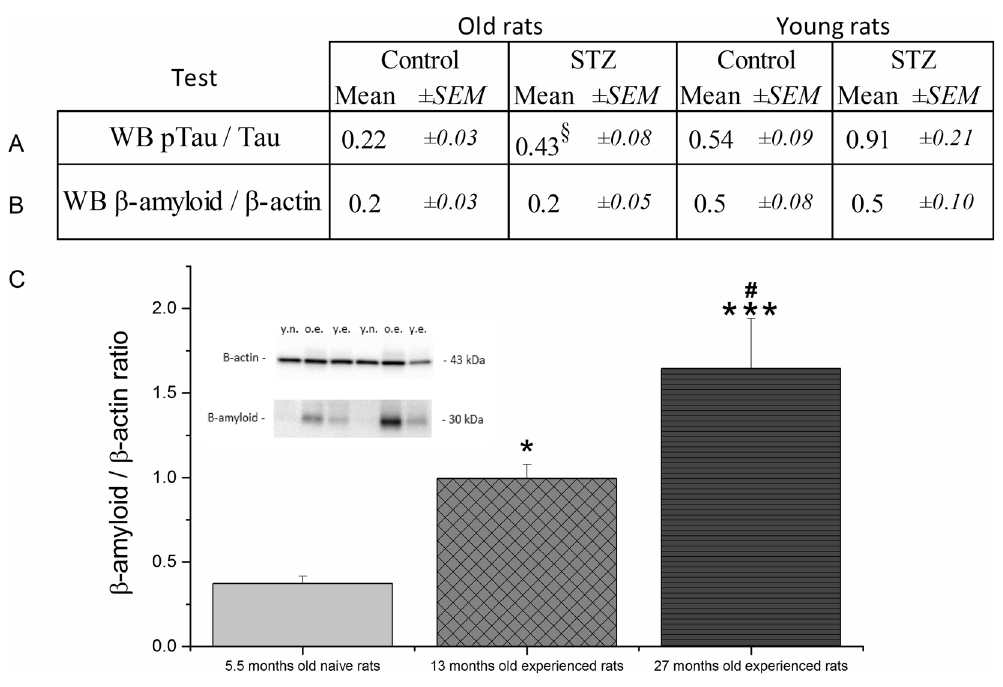
Figure 7. Results of the western blot assays. ( A ) Phospho-tau/tau ratio. ‘Old rats’ column: §:p = 0.016 significant difference vs control ((Mann–Whitney U-test U = 18; because of variance inhomogeneity